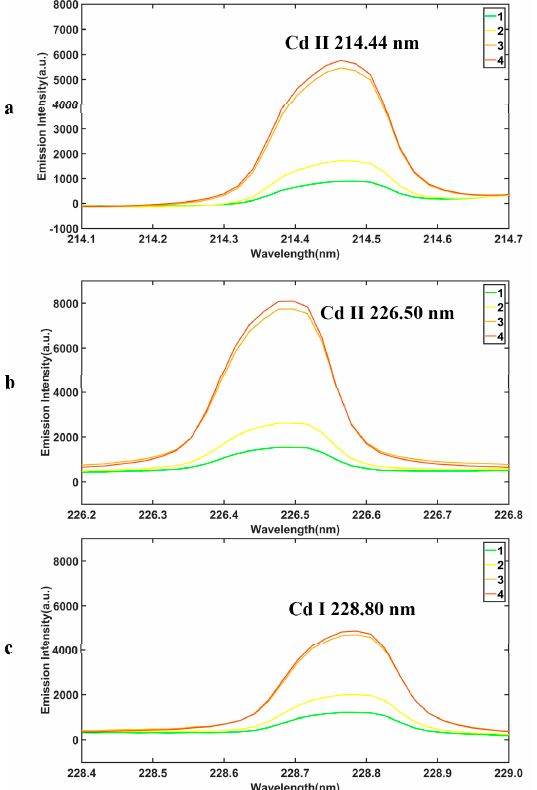
Figure 2. Three Cd spectral peaks of Figure 1( d ). Cd Ⅱ 214.44 nm peak ( a ), Cd Ⅱ 226.50 nm peak ( b ), Cd Ⅰ 228.80 nm peak ( c ).